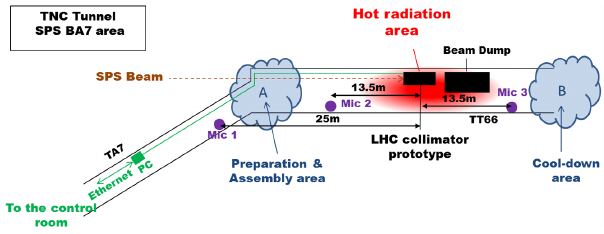
FIG. 4. Installation layout for the collimator at